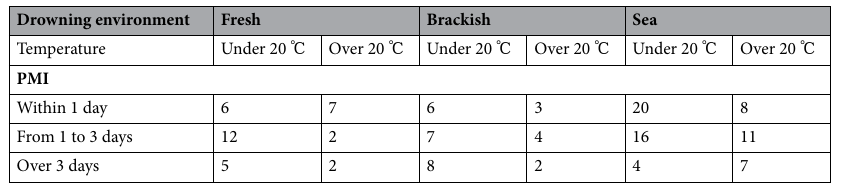
Table 4. The case number classified to drowning environment, water temperature, and